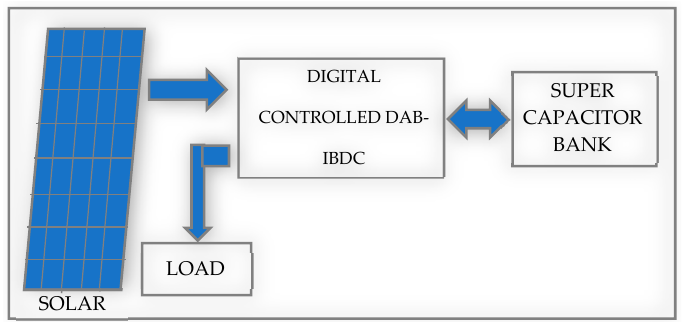
Figure 1. Block diagram of a standalone photovoltaic power system.